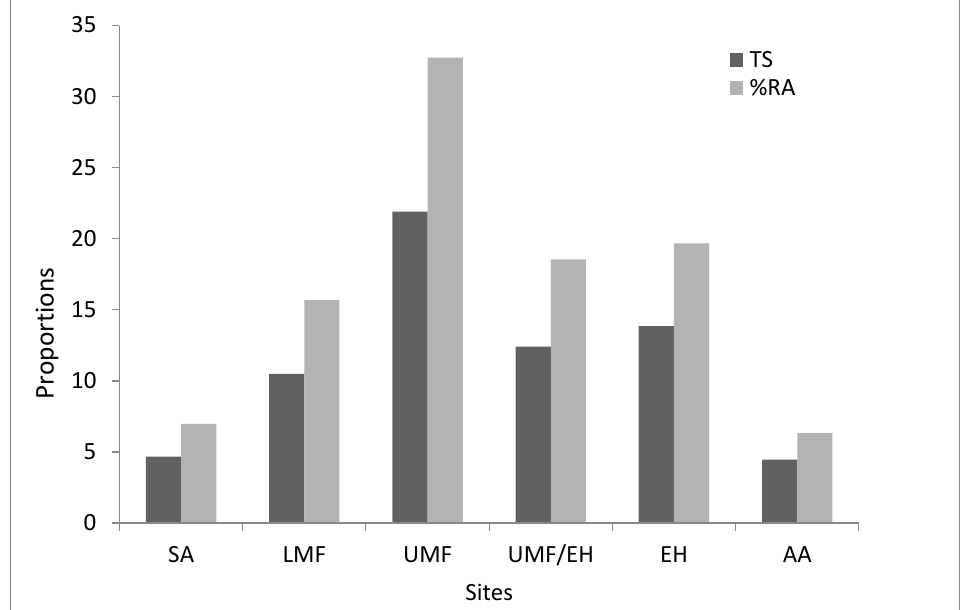
Figure 4. Small mammals’s percentage of relative abundance (%RA) and percentage of trap success (TS) across sites.